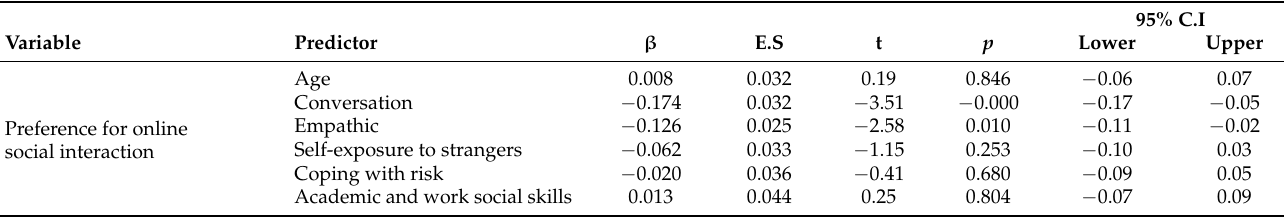
Table 2. Summary of the multiple linear regression model for the preference for online social interaction variable in line with the predictor variables included in the analysis.